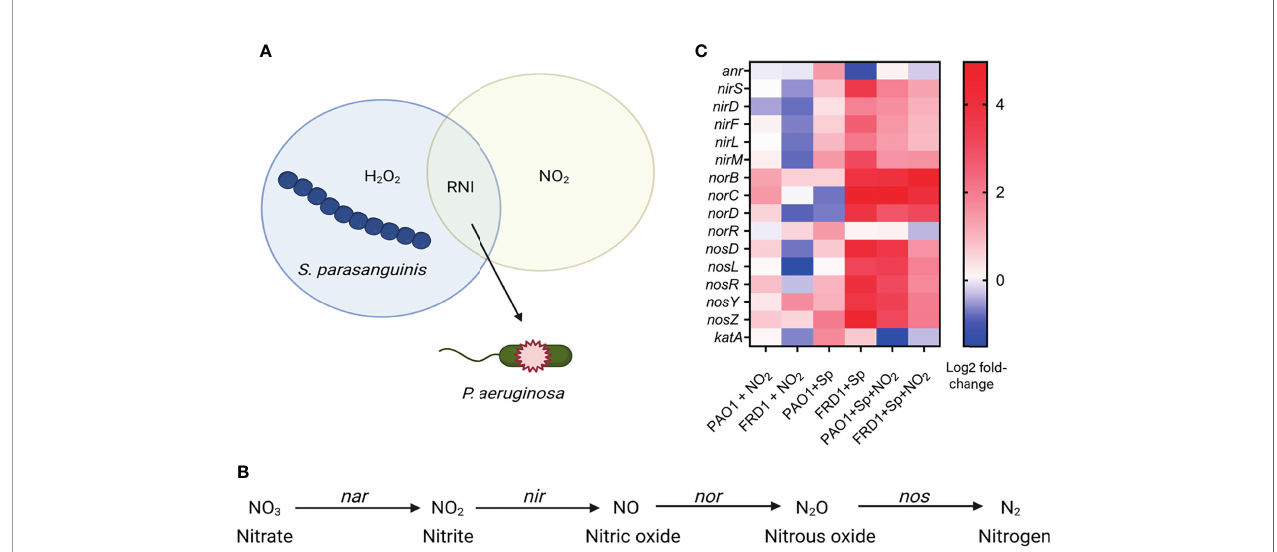
FIGURE 1 | S. parasanguinis dysregulates the P. aeruginosa nitrate reduction transcriptome. (A) Oral commensal Streptococci such as S. parasanguinis produce hydrogen peroxide that can react with endogenous nitrite to form reactive nitrogen intermediates (RNI) such as peroxynitrite that are lethal to P. aeruginosa. (B) P. aeruginosa denitri fi cation pathway. Nitrate is reduced by nitrate reductase (Nar), nitrite is reduced by nitrite reductase (Nir), nitric oxide is reduced by nitric oxide reductase (Nor), nitrous oxide is reduced by nitrous oxide reductase (Nos). (C) Heat map generated from RNA sequencing showing the relative transcription of genes involved in denitri fi cation between PAO1 and FRD1 in the presence of nitrite, S. parsanguinis , and nitrite and S. parsanguinis